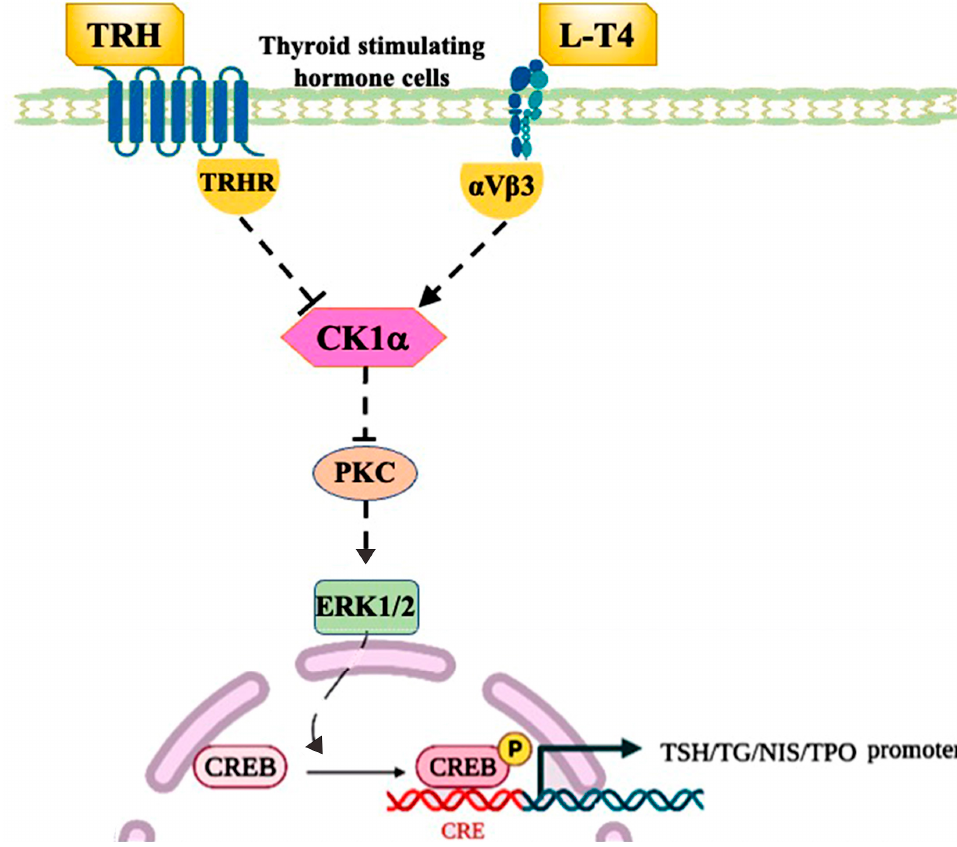
Figure 9. CK1 α regulation of TSH. TRH activates PKC through the TRH receptor, which increases the phosphorylation of ERK1/2, thereby activating CREB and promoting the expression of genes encoding TSH subunits. L-T4 activates the integrin α V β 3 membrane receptor with a rapid non-ge- nomic e ff ect to inhibit PKC/ERK/CREB signaling, thus inhibiting TSH transcription. Arrows indi- cate stimulation; T bars indicate inhibition.